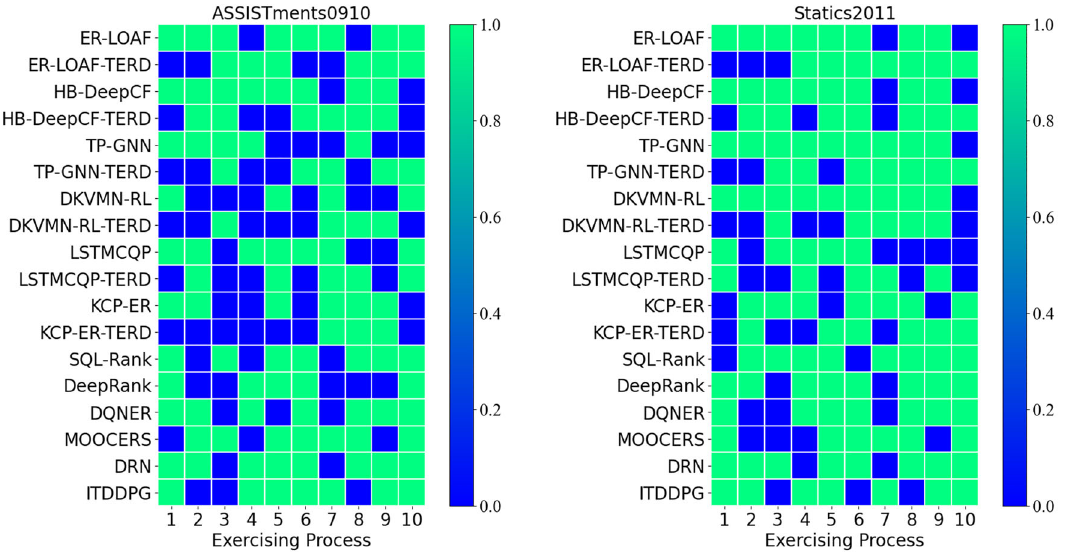
Fig. 8 The visualization of students’ exercising